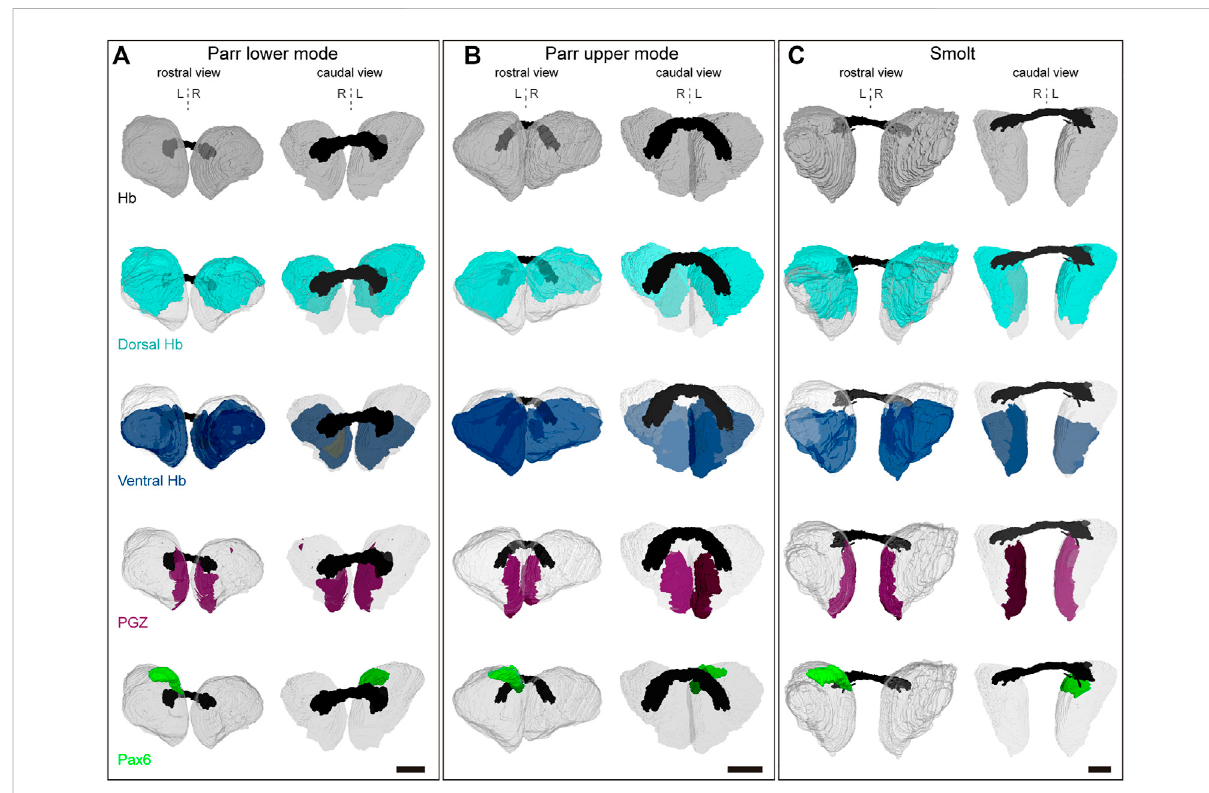
FIGURE 5 3D reconstructions of habenulae. (A – C) show 3D reconstructions of habenulae respectively in a parr lower mode, parr upper mode and smolt, with rostral and caudal views on the left and on the right as indicated. The whole habenulae are shown in grey ( fi rst line), the dorsal habenulae (including the pax6 dorsal left nucleus) in light blue (second line), the ventral habenulae (comprising kiss1 and sox1b positive territories) in dark blue (third line), the posterior growth zone (PGZ) in purple (fourth line) and the pax6 left dorsal nucleus in green ( fi fth line). The habenular commissure is in black. A dotted vertical line indicates the midline. Abbreviations: Hb, habenulae; L, left; R, right. Scale bars = 150 μ